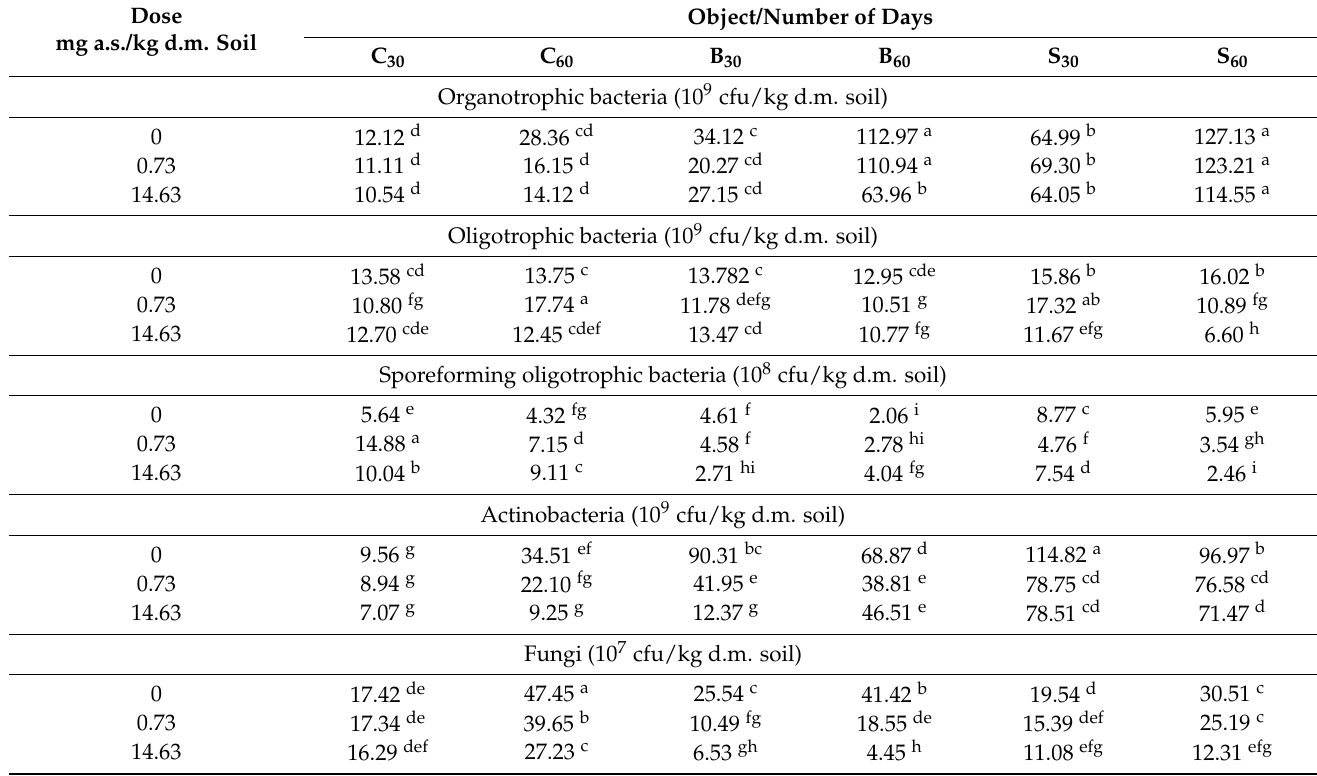
substance. The same letters denote homogeneous groups within a given microorganisms group.